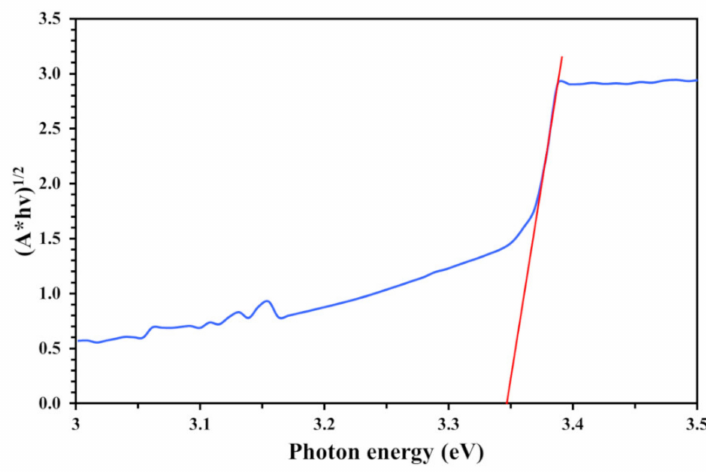
Figure 6. Tauc plot for TiO 2 -coated PVC